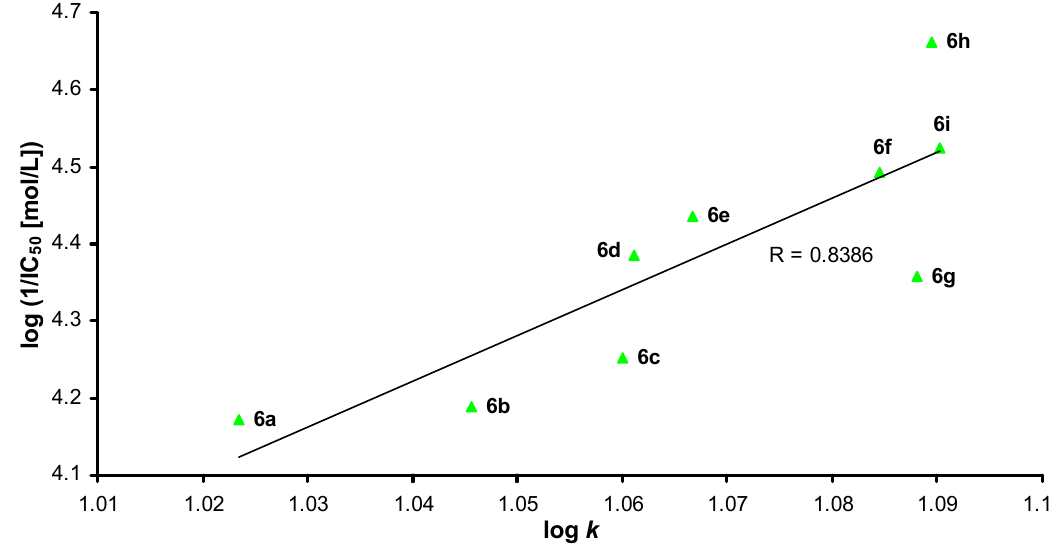
Figure 3. Dependence of AChE inhibition (log 1/IC compounds 6 expressed as log k